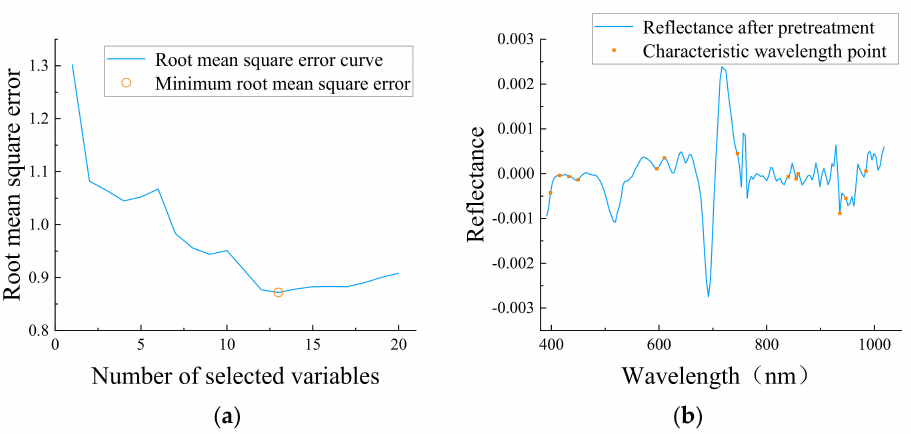
Figure 15. MCUVE–CARS–SPA screening the optimal combination wavelength results. ( a ) Trend of RMSEP value with the number of wavelengths. ( b ) Corresponding characteristic